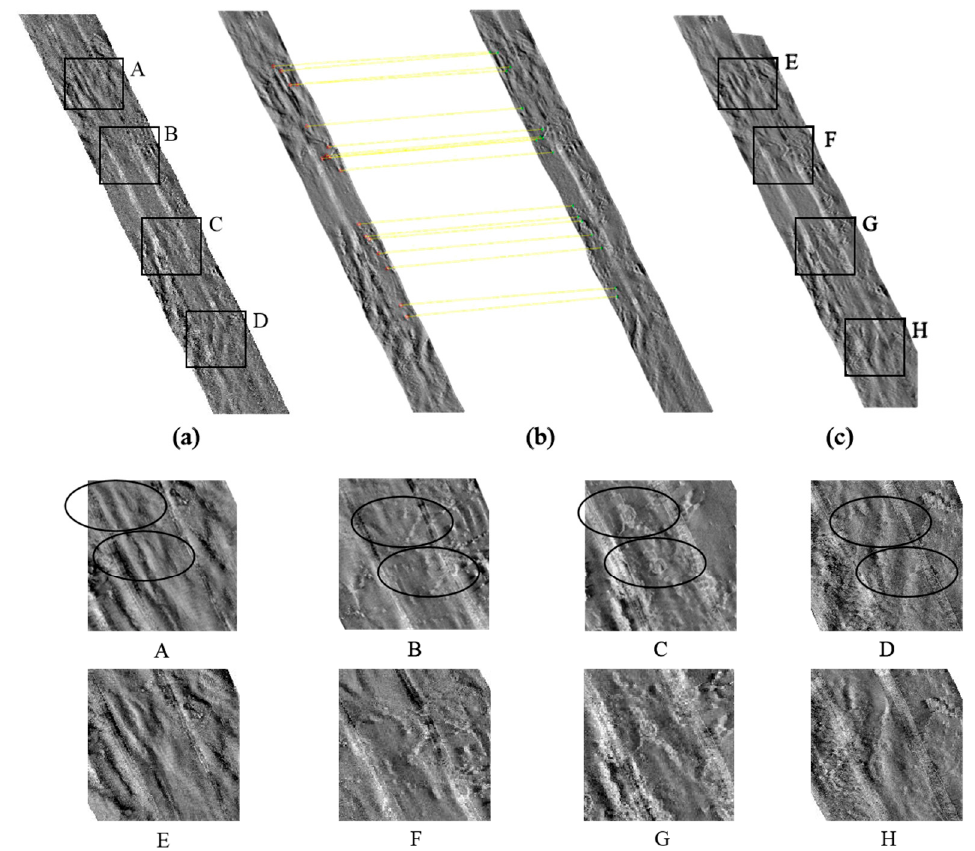
Figure 4. Strip image registration. A–D and E–H are four areas selected from ( a ) and ( c ) respectively. ( b ) shows the registration process of strips. It can be seen that there was significant dislocation in A–D. After strip registration, the dislocation effect largely disappeared in E–H.